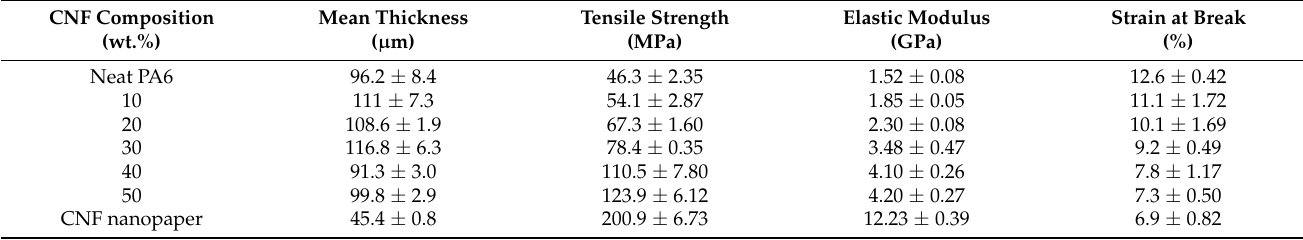
Table 3. Tensile properties for the control samples and PA6-CNF nanocomposites. CNF Composition